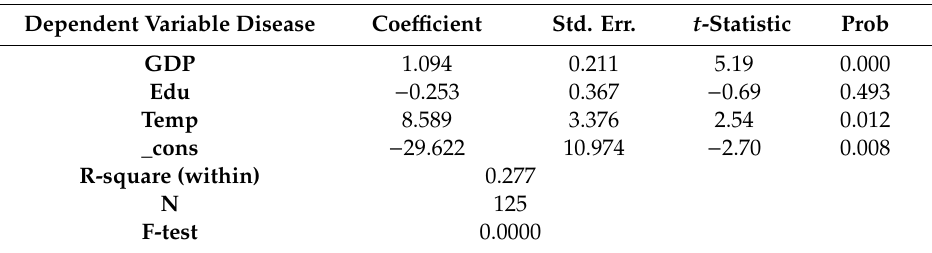
Table 1. Results of panel fixed-e ff ect